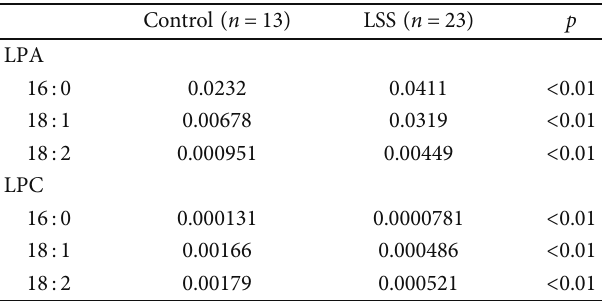
Table 2: LPA and LPC levels in CSF between LSS patients and controls.